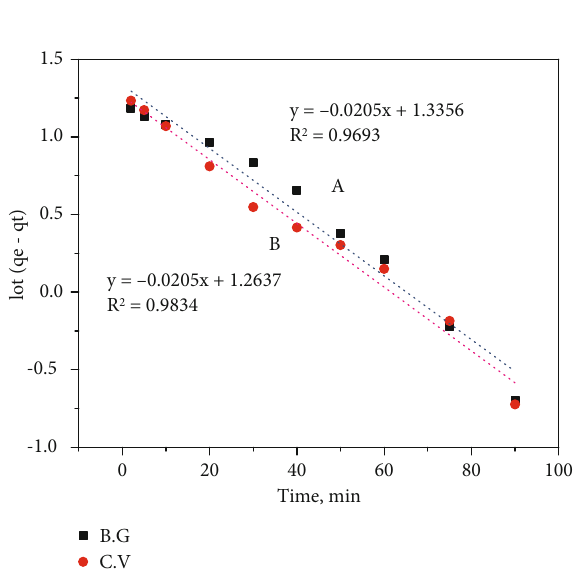
Figure 14: Lagergren plot of B.G. and C.V. dyes ’ adsorption onto the binary P3NT/30%AgTiO NCs versus time. Experimental 2 conditions are represented in the batch extraction step.